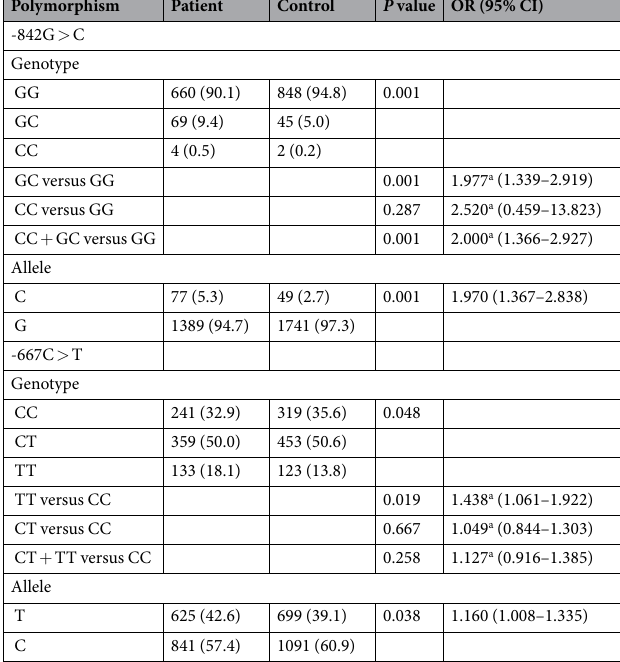
Table 3). Compared to the most common -842G-667C haplotype, -842G-667T haplotype and -842C-667C hap- lotype showed a significantly increased risk of nasopharyngeal carcinoma (OR = 1.215, 95% CI = 1.053–1.402, P = 0.008 and OR = 2.268, 95% CI = 1.530–3.362, P = 0.001, respectively, Table 3); -842C-667T haplotype with a for -842C-667T haplotype was small, power calculation was performed for the specific statistical analysis. The result indicated a small power (8.9%) and the association analysis should be considered as inconclusive at this point. Larger sample size is needed to make a conclusion.